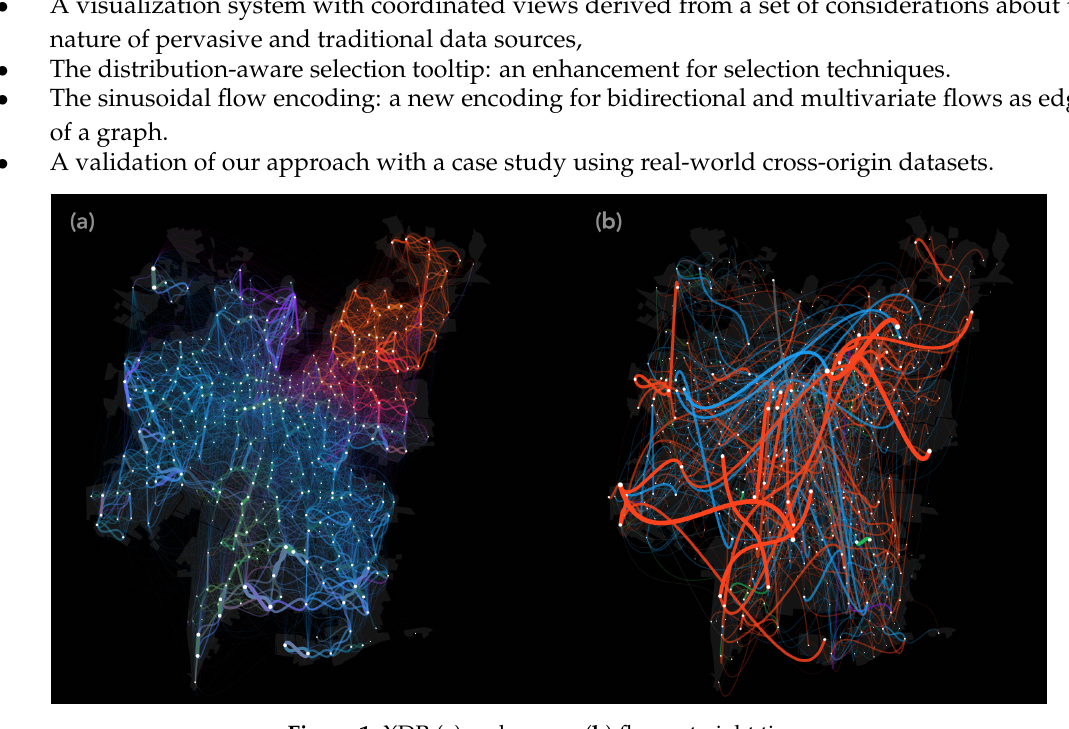
Figure 1. XDR ( a ) and survey ( b ) flows at night